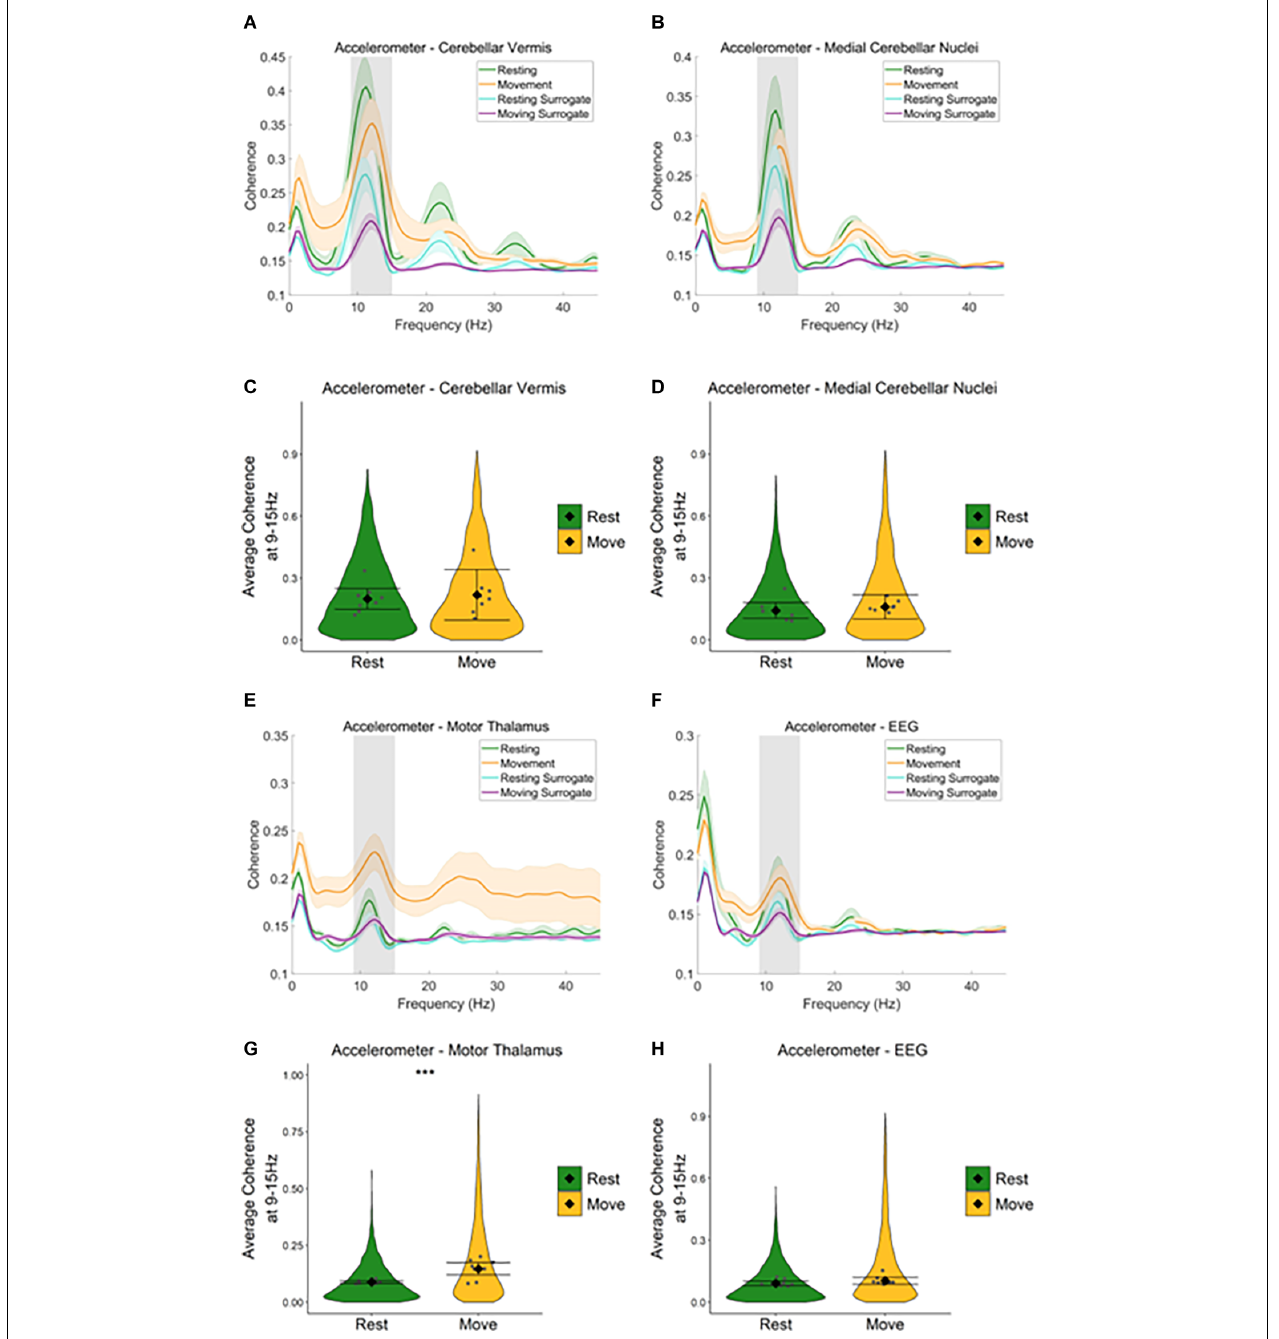
FIGURE 5 | Neural oscillations across the cerebello-thalamo-cortical network correlate with harmaline-induced behavioural tremor. (A,B) Mean ( ± SE) (A) cerebellar cortex-kinematic ( n = 8 rats), (B) cerebellar nuclei-kinematic ( n = 7 rats) during resting and movement for real and surrogate datasets. The solid line represents mean coherence, and the coloured shaded areas represent SE. The grey area represents the tremor frequency. (C,D) Average surrogate-corrected (C) cerebellar cortex-kinematic, (D) cerebellar nuclei-kinematic coherence at the tremor peak across all epochs with significant coherence (pooled across rats). Individual grey points represent the mean per rat. Fixed effects parameter estimates ( ± CI) representing predicted mean estimates are shown by (cid:7) and corresponding error bars. ∗∗∗ indicates p < 0.001 (E) thalamic-kinematic ((textitn = 8 rats), and (F) cortico-kinematic (textitn = 6 rats) coherence during resting and movement for real and surrogate datasets. The solid line represents mean coherence, and the coloured shaded areas represent SE. The grey area represents the tremor frequency. (G,H) Average surrogate-corrected (G) thalamic-kinematic and (H) cortico-kinematic coherence at the tremor peak across all epochs with significant coherence (pooled across rats). Individual grey points represent the mean per rat. Fixed effects parameter estimates ( ± CI) representing predicted mean estimates are shown by (cid:7) and corresponding error bars. ∗∗∗ indicates p < 0.001.